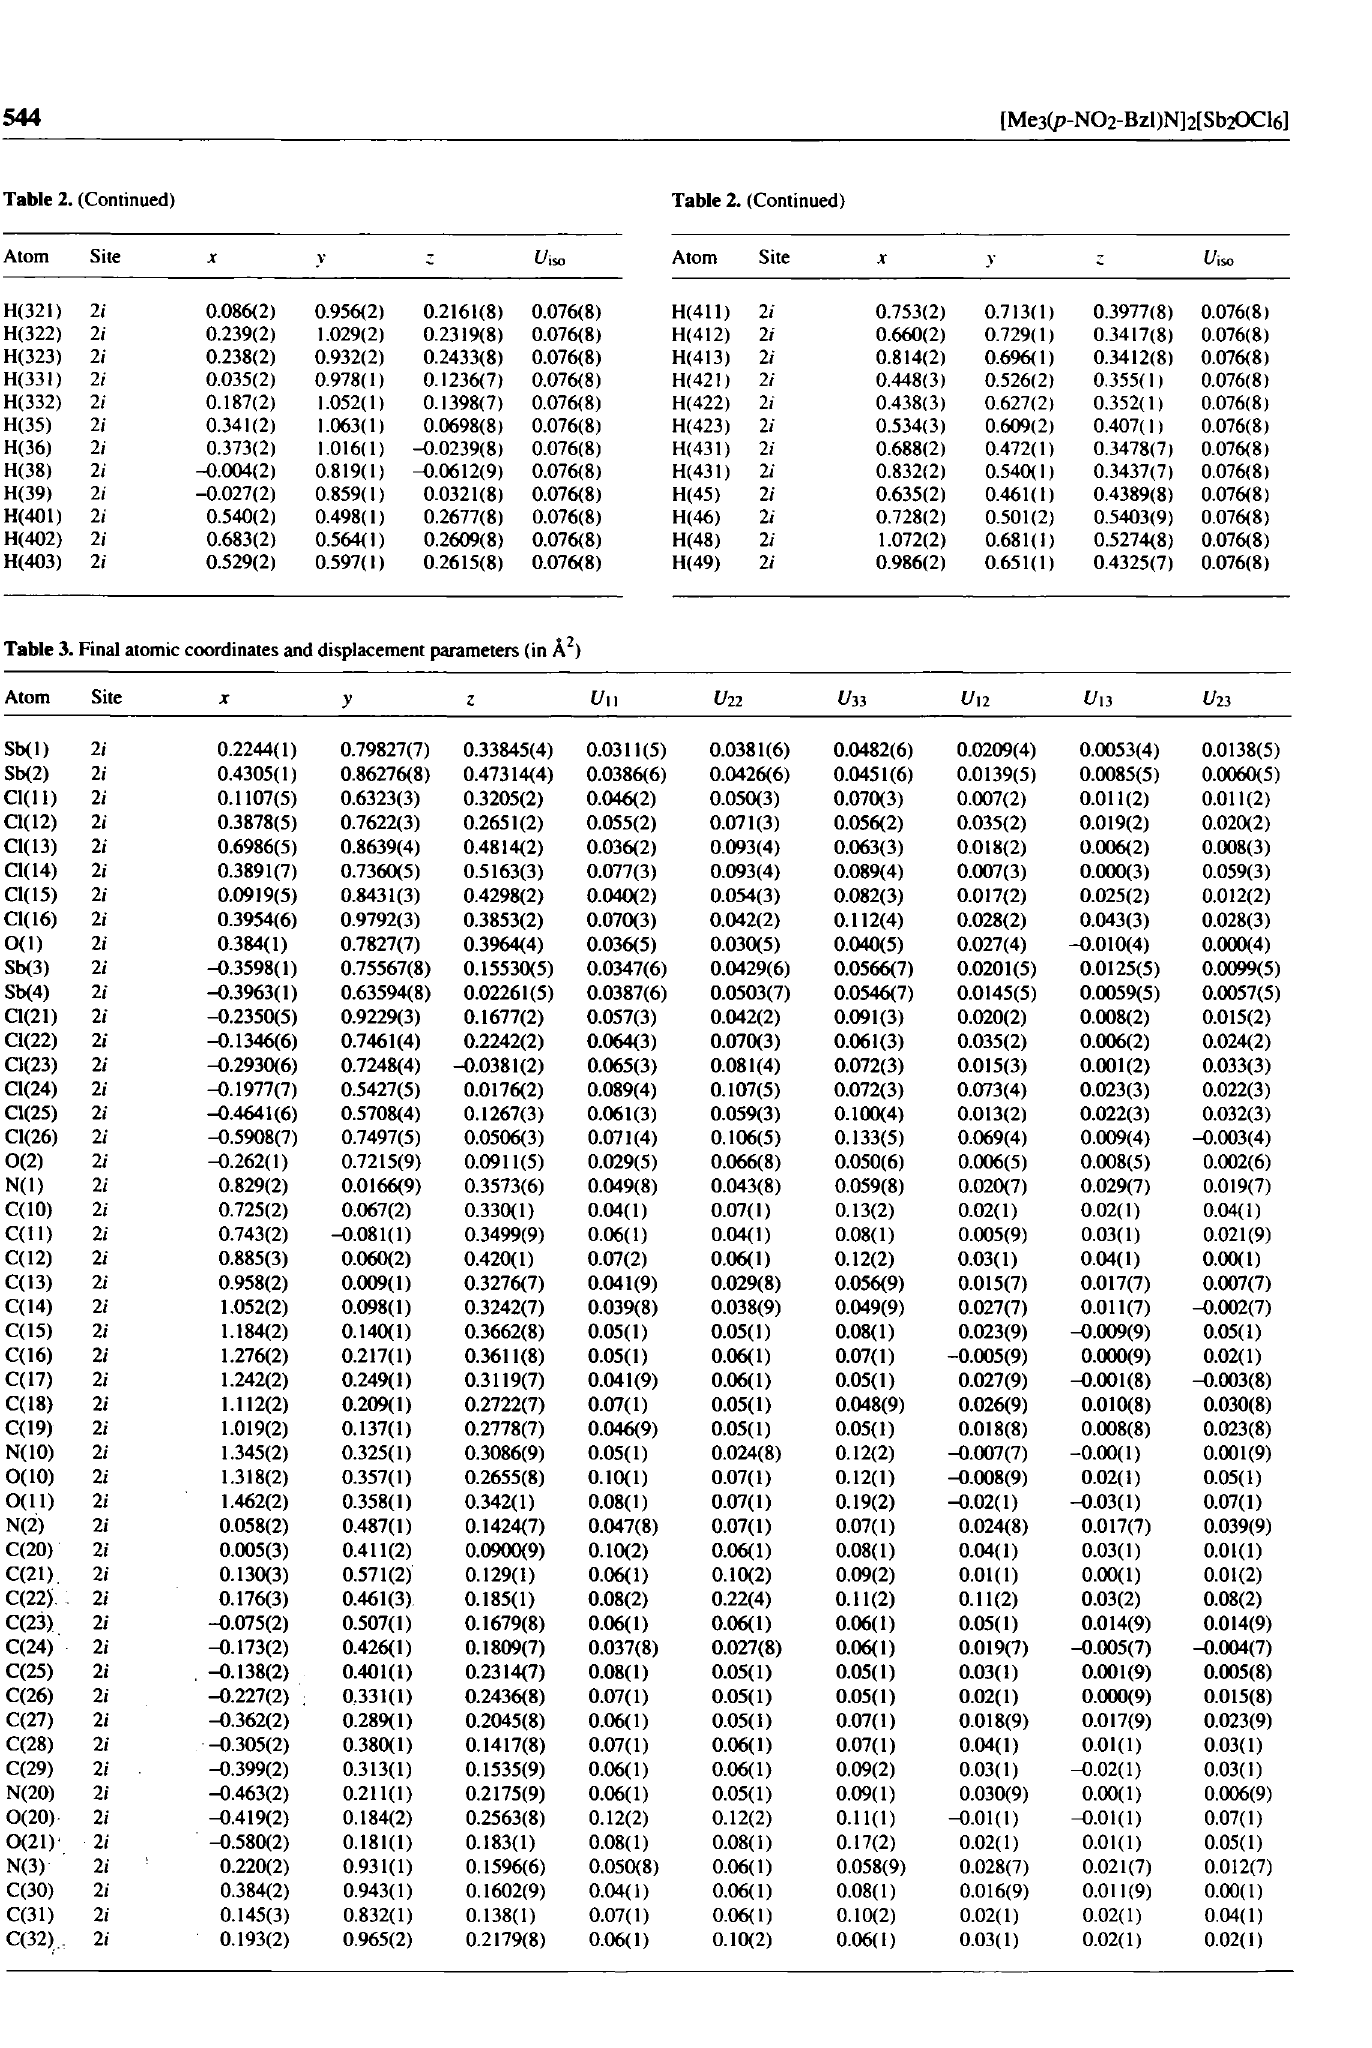
Table 3. Final atomic coordinates and displacement parameters (in